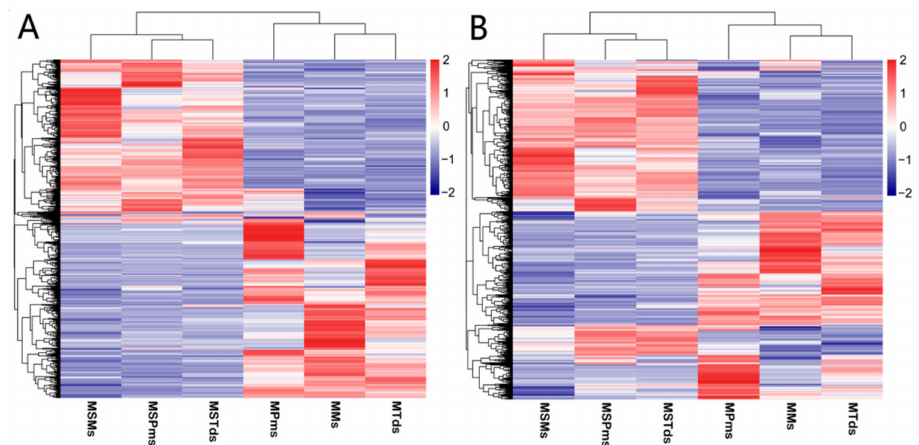
Figure 4. ( A ) Hierarchical clustering of lncRNAs di ff erentially expressed at di ff erent stages in the development of cotton. ( B ) Hierarchical clustering of cis - target genes of lncRNAs di ff erentially expressed at di ff erent stages in cotton development. Data are expressed as FPKM. Red: relatively high expression; Blue: relatively low expression. The bar code on the right represents the color scale of the log 2 values. MS—Male sterile line; M—Maintainer line; Pms—pollen mother cell stage; Tds—tetrad stage; Ms—mononuclear stage.